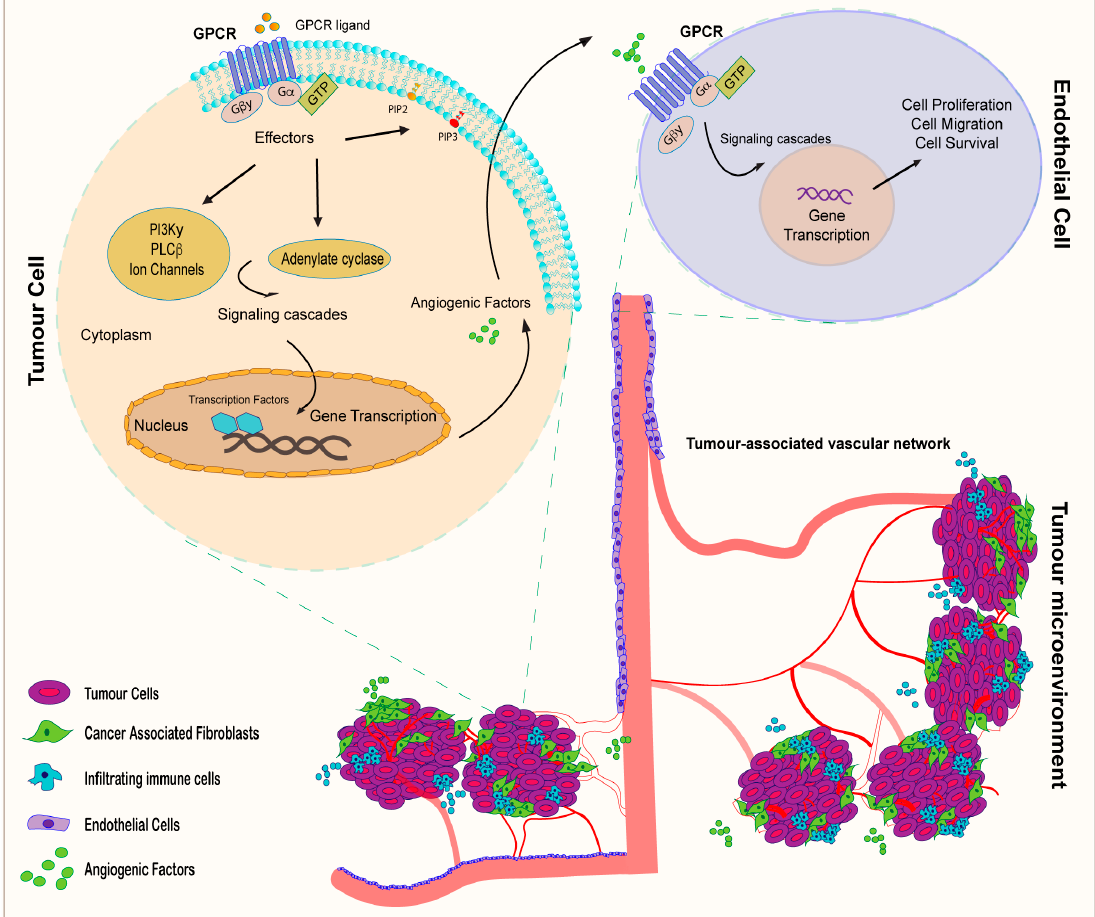
Figure 2. GPCRs involved in tumor angiogenesis. GPCR signaling mediates the cross-communication between stromal, endothelial and cancer cells toward neoangiogenesis and tumor progression.